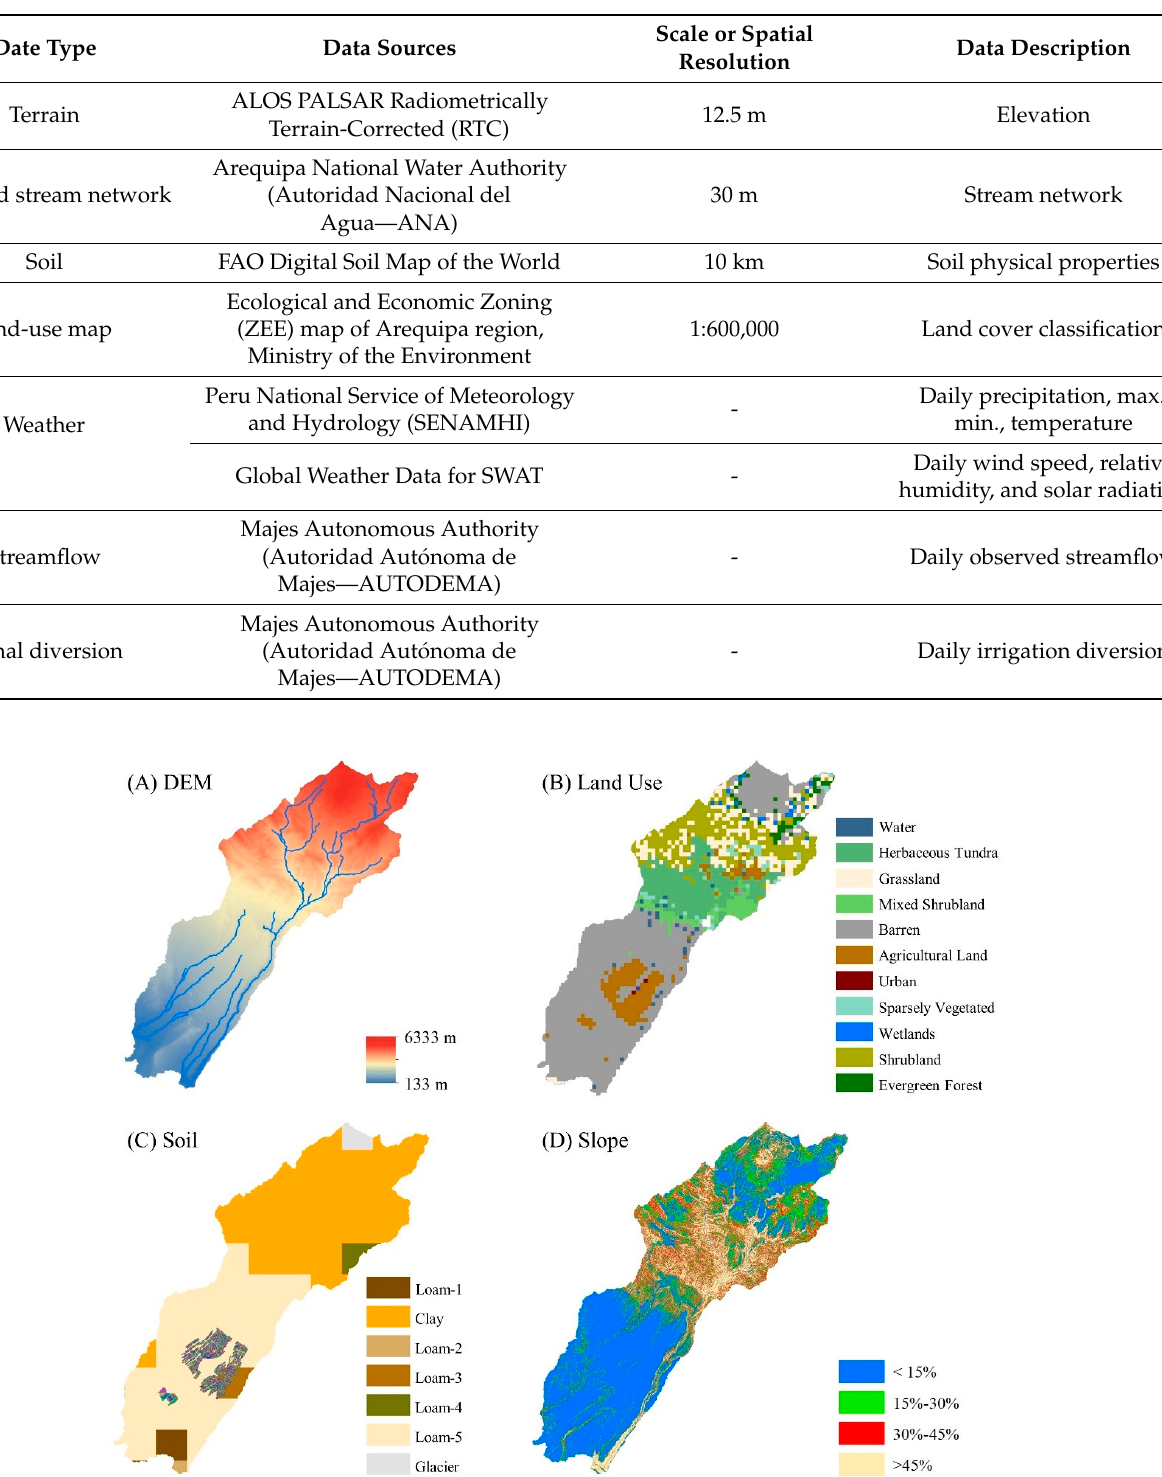
Table 1. Input datasets for the Soil Water Assessment Tool (SWAT) model.